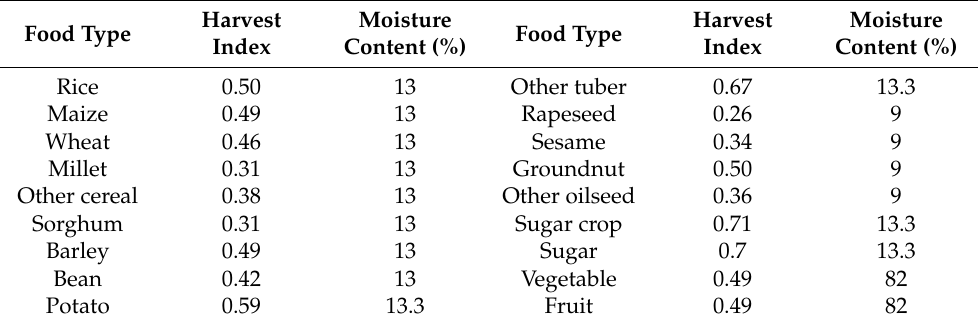
Table 2. The harvest index and moisture content of different food